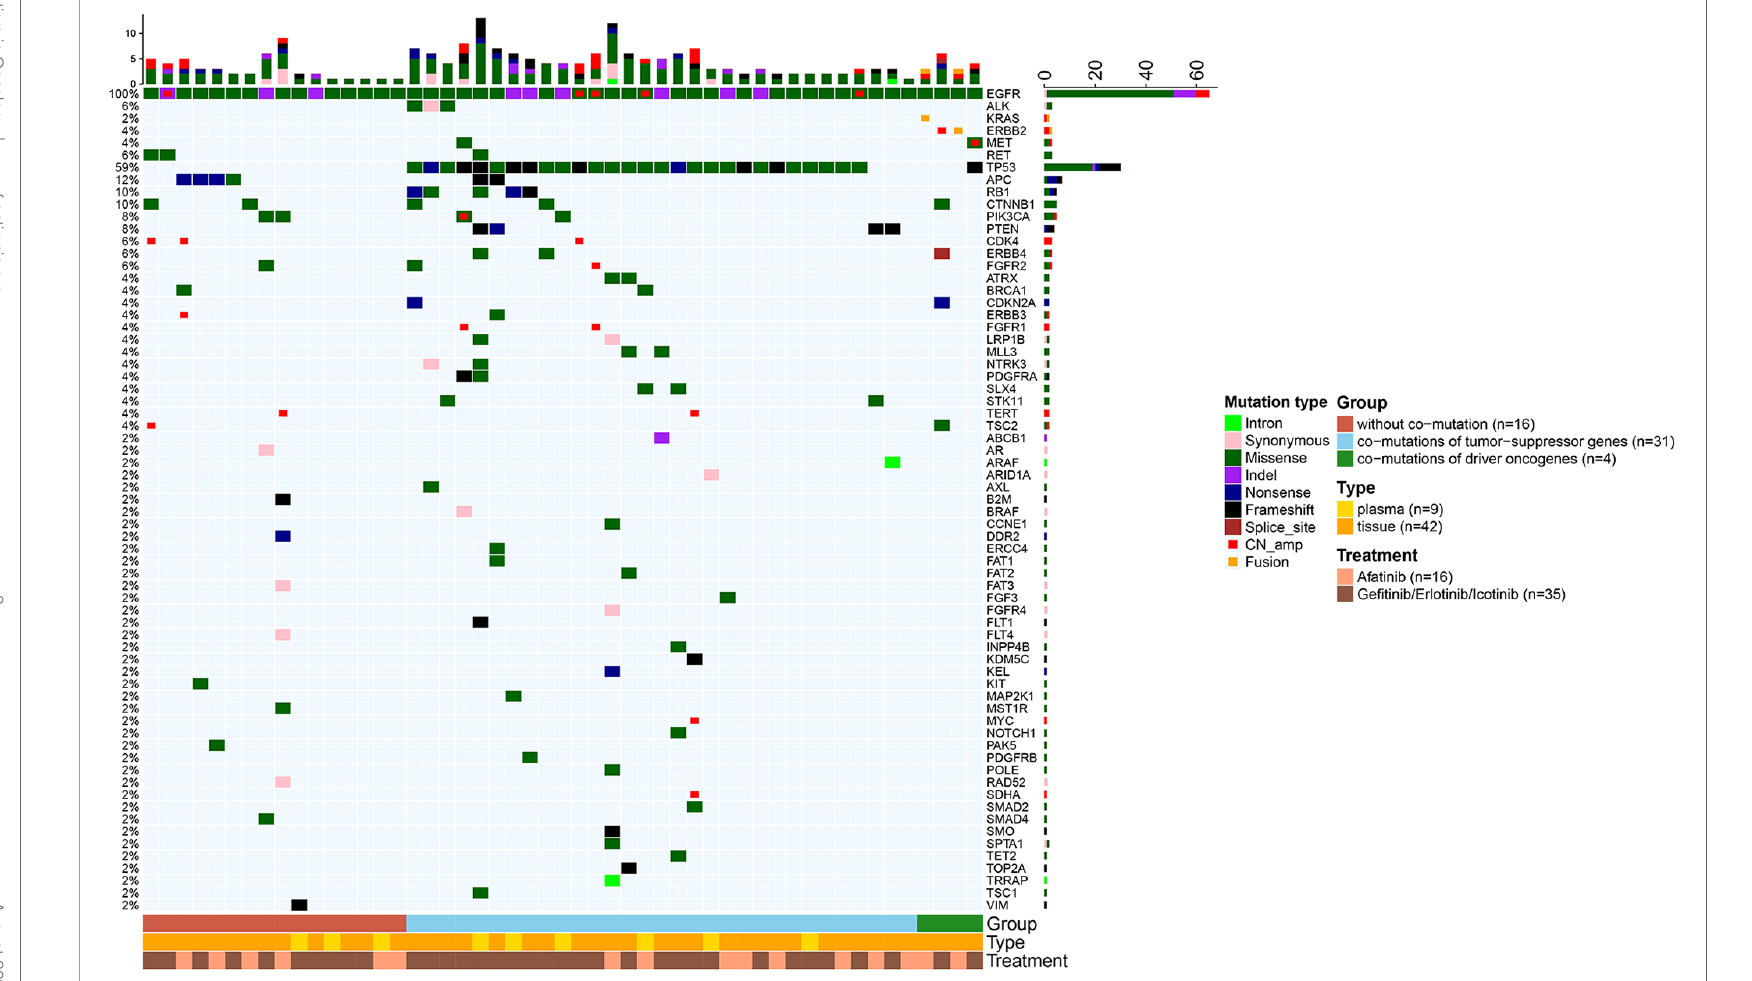
FIGURE 5 | Heatmaps of genetic alterations of the 51 uncommon EGFR mutated patients who received NGS for testing multiple cancer-related genes. Patients were strati fi ed into three subgroups according to the identi fi ed concurrent genetic